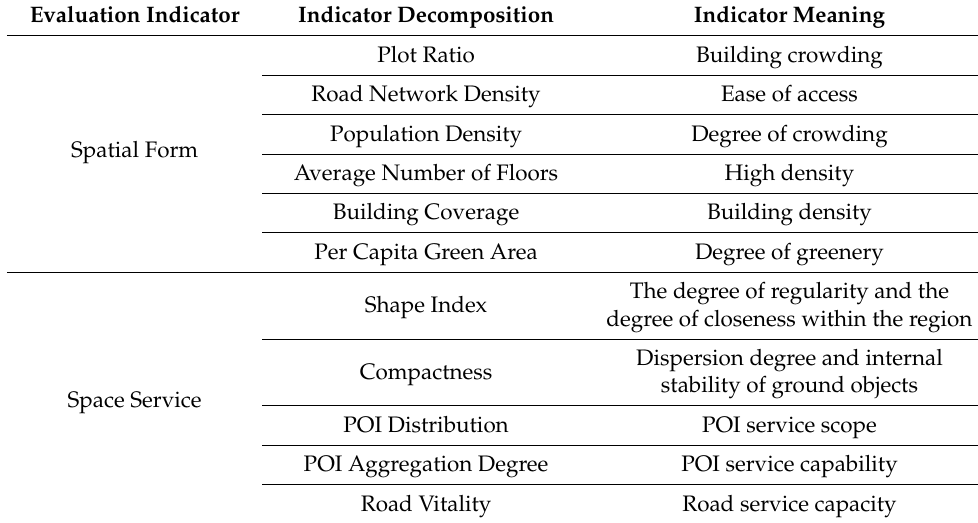
Table 1. Community spatial evaluation